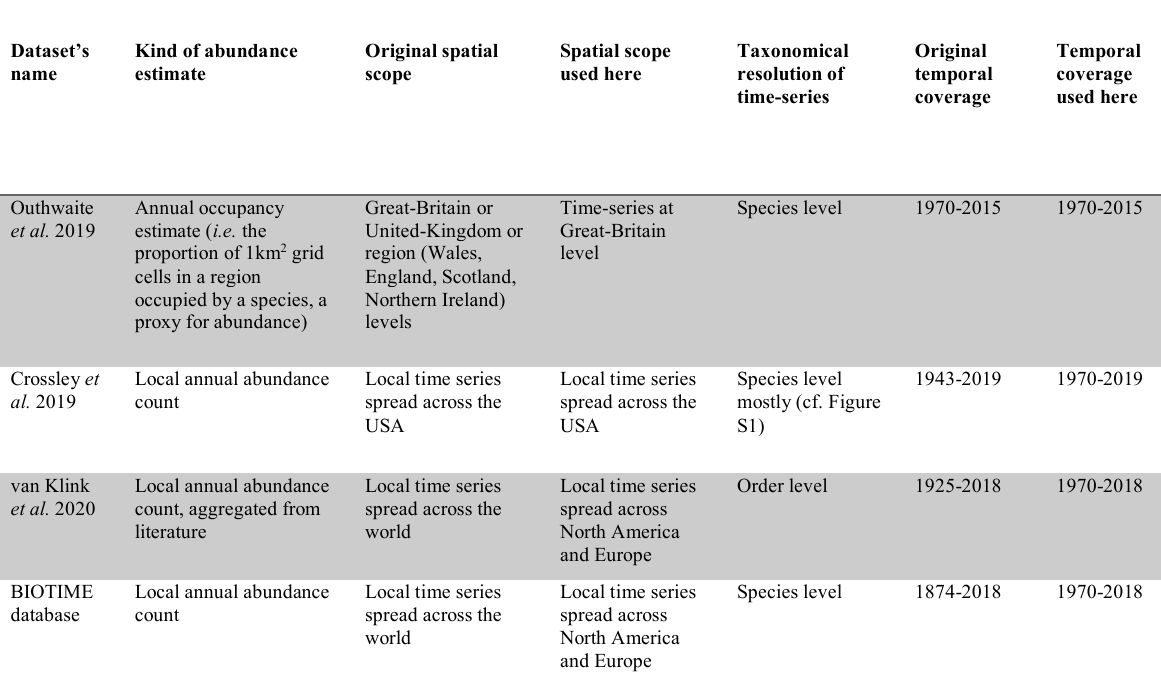
Table S1: Description of the 4 datasets